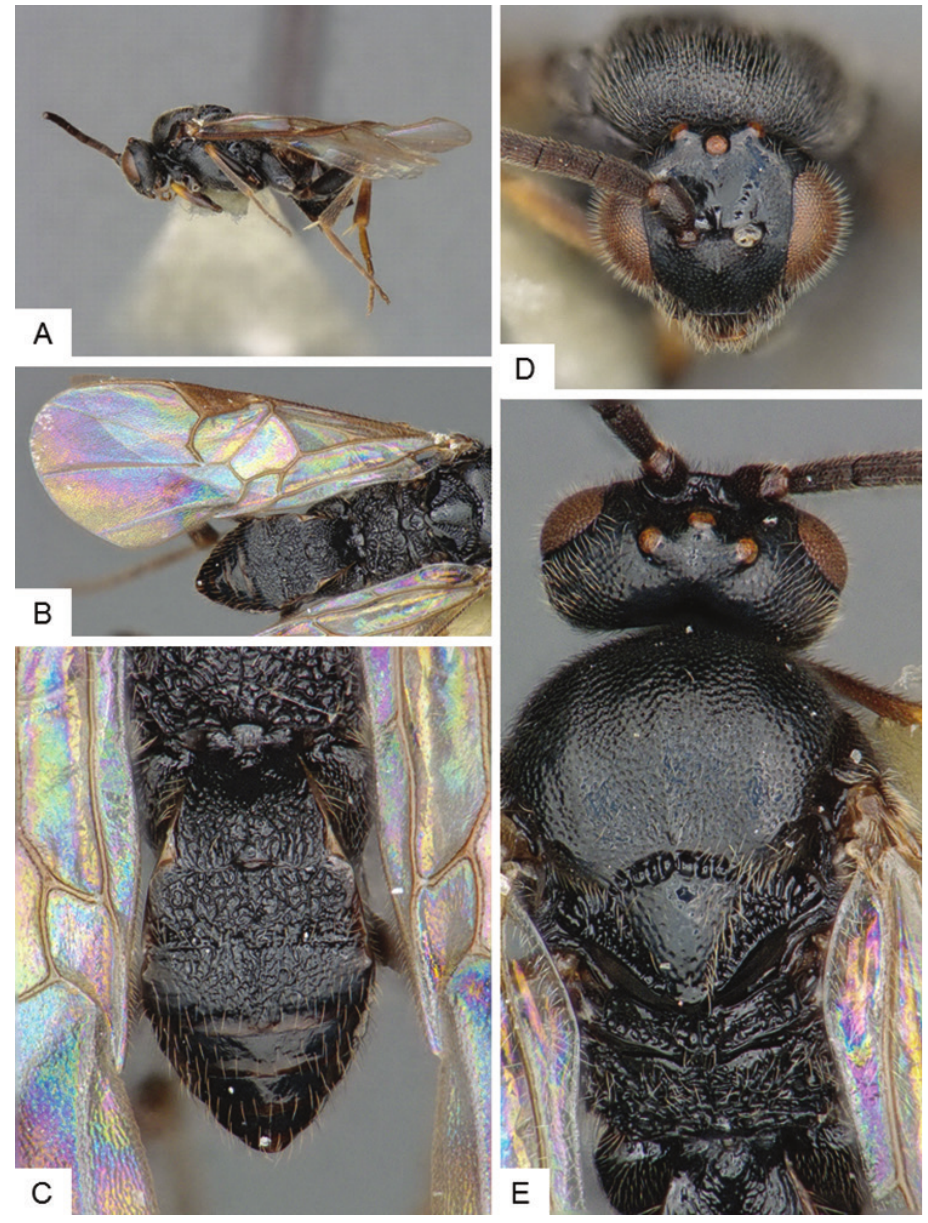
Figure 3. Cotesia eliniae . A Habitus, lateral B Fore wing C Metasoma, dorsal D Head, frontal-dorsal E Head and mesosoma,